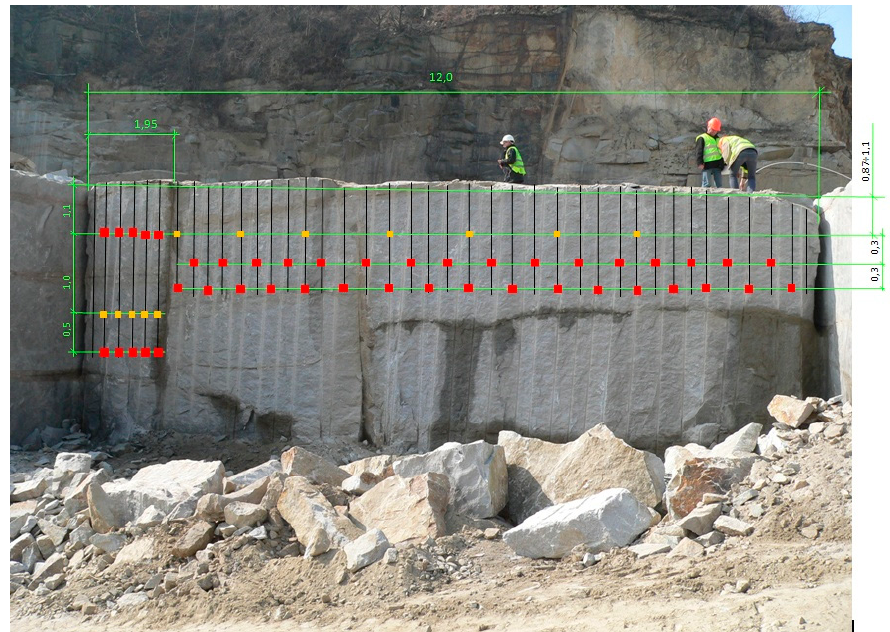
Figure 7. Diagram of RSP arrangement when mining a block of granite.